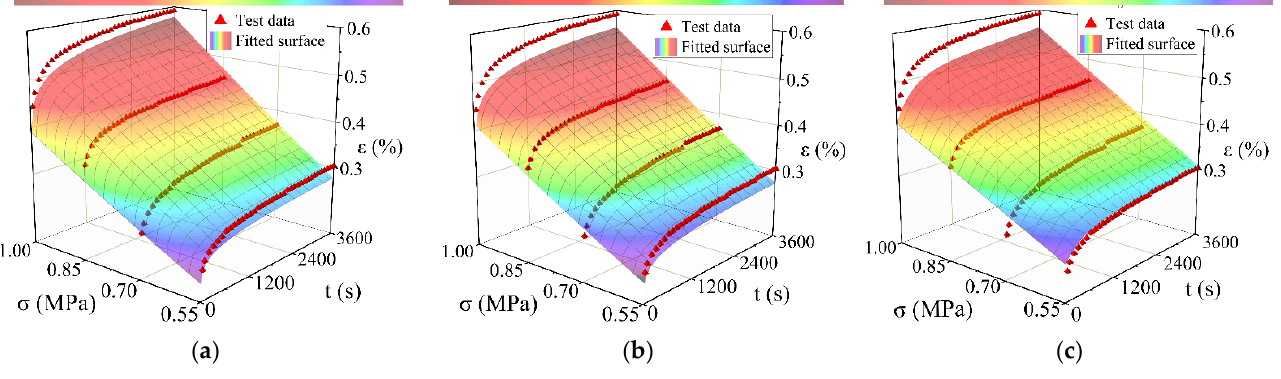
Figure 8. Comparison between test data points with the different model fitted surfaces at 20 °C: ( a ) Fitting result of the time hardening model; ( b ) Fitting result of the modified time hardening model; ( c ) Fitting result of the modified Burgers model.